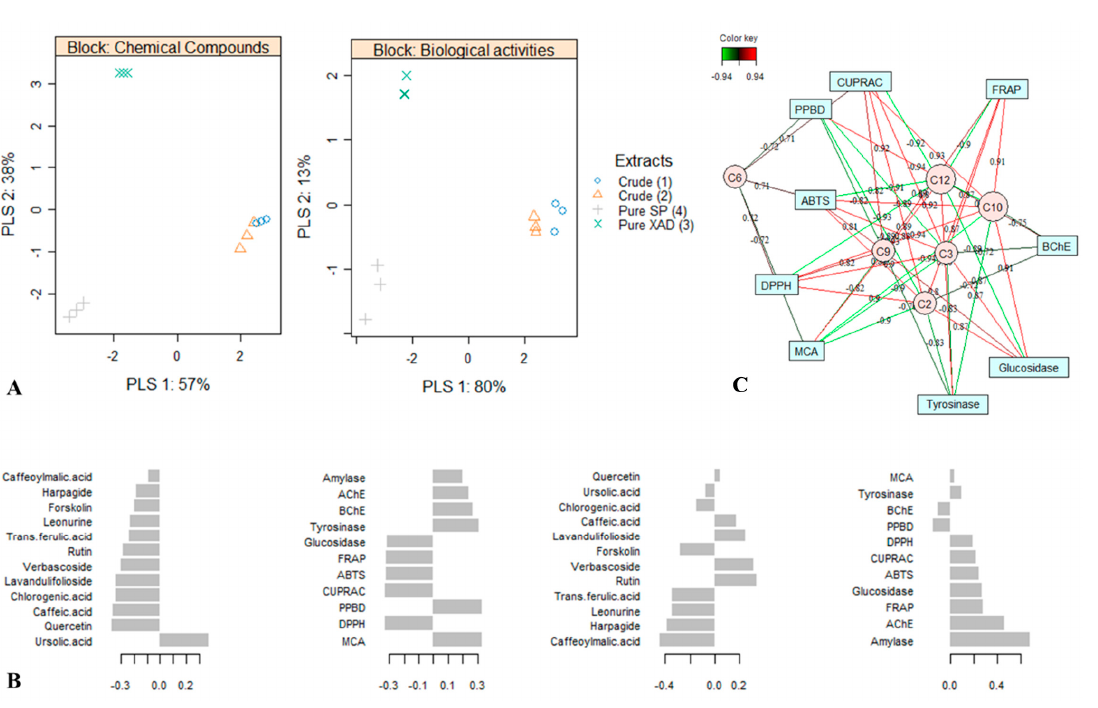
Figure 3. Partial least squared analysis. ( A ) Biplot describing the phytochemical and bioactivity variation between the extracts. ( B ) Loadings plot of each variable selected on the first two functions in each data matrix. ( C ) Network displaying the correlation between the bioactivities and phytochemical compounds. C2 = chlorogenic acid, C3 = caffeic acid, C6 = verbascoside, C9 = lavandulifolioside, C10 = quercetin, C12 = ursolic